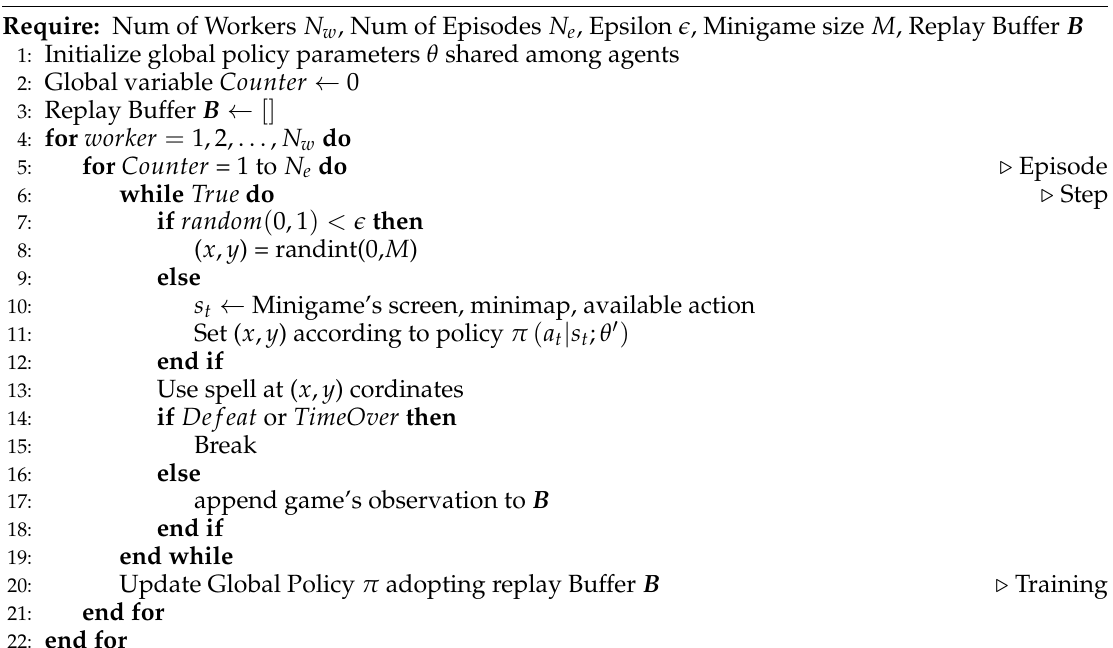
Algorithm 1 A3C Minigame Training Method